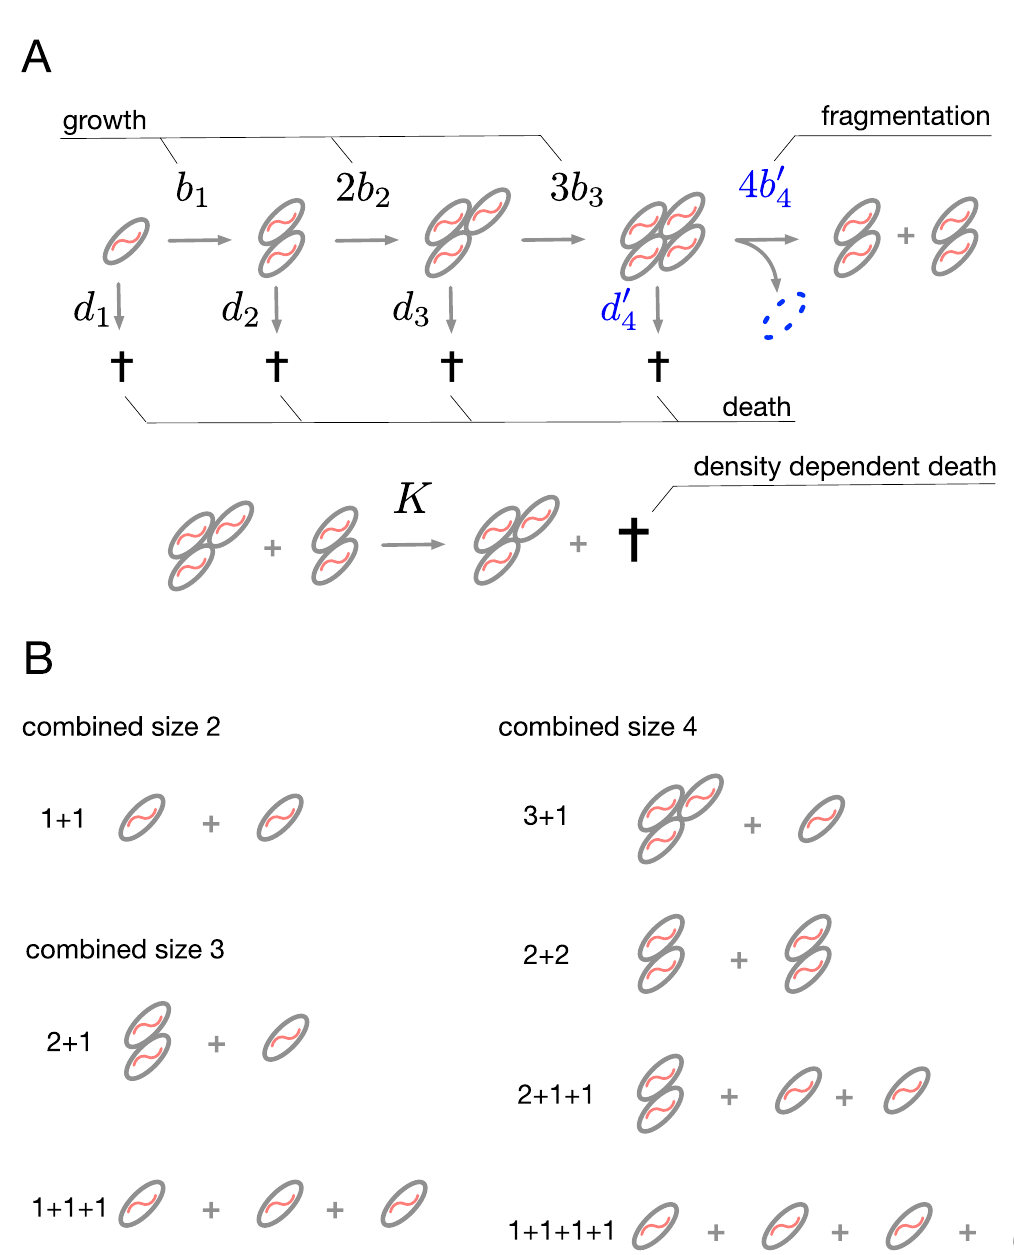
Fig 2. Model of life cycles. ( A ) Multicellular units increase in size and fragment to produce new units. Cell division ( b i ) and unit death ( d i ) rates depend on the size of the unit and are determined by the environment. If the fragmentation process is costly, the division rate at the maturity size may be smaller than prescribed by the environment alone b 0 maturity size may be larger than prescribed by the environment alone d 0 fragmentation (highlighted in blue). In this example, m = 4, so the unit fragments when it reaches five cells, one cell is lost in fragmentation and the remaining four are split by the fragmentation mode 2+2. ( B ) The fragmentation mode of cell clusters can be described by a sum of integers. All possible fragmentations of units of size 2, 3, and 4 are presented here. Different life cycles have different growth rates and we are looking for the fastest growth in this context.